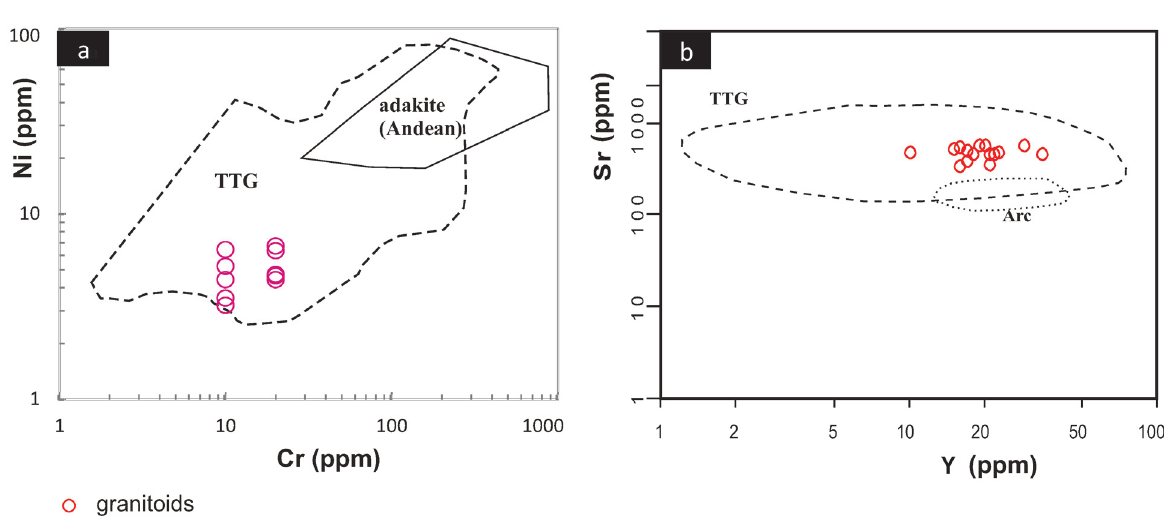
Fig. 10. (a) Cr vs Ni variation plots for granitoids. Boundaries of tonalites–trondhjemites–granodiorites (TTGs) and adakite fields are from Condie (2005). (b) Sr vs Y diagram. Archaean TTGs (Martin & Moyen 2002); ‘ordinary’ arc magmas (GEOROC project,